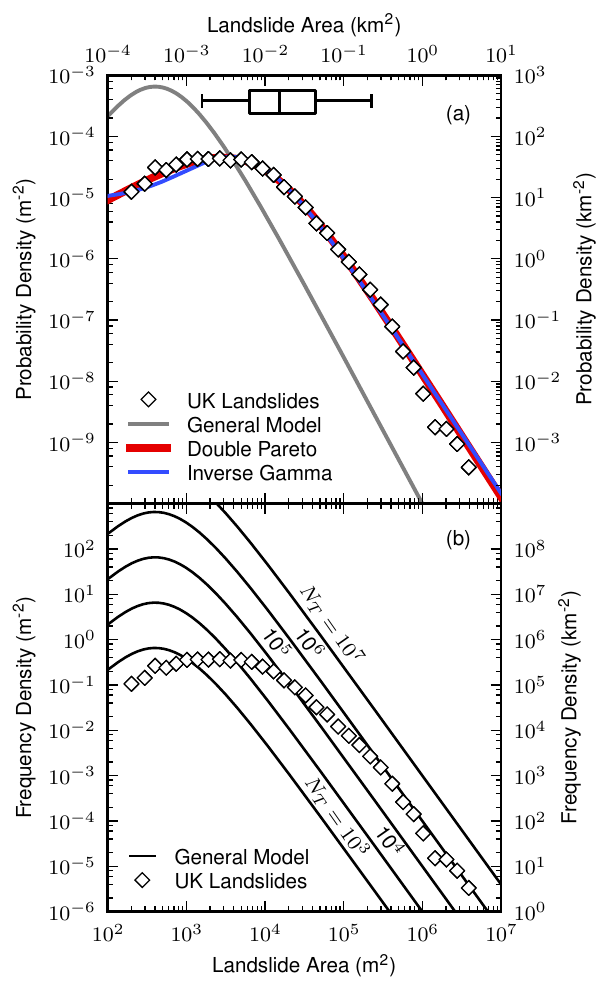
Figure 3. (a) Probability distribution of landslide deposit area for n = 8453 landslides in the UK organised into bins spaced evenly in logarithmic space (open diamonds). Solid red and blue lines show MLE of a double Pareto function ( α p = 1 . 01 ± 0 . 01; β = 1 . 71 ± 0 . 07; A peak = 8 . 09 ± 0 . 6 × 10 − 3 km 2 ) and inverse gamma function ( α g = 0 . 95 ± 0 . 02; r = 10 . 9 ± 0 . 4 × 10 − 3 km 2 ; s = − 1 . 91 ± 0 . 08 × 10 − 3 km 2 ), respectively (error ranges based on one standard deviation of boot- strapped MLE parameters). The grey line is a proposed general dis- tribution for landslides put forward by Malamud et al. (2004). Box plot shows the median (central line), upper / lower quartiles (extent of rectangle) and 5th and 95th percentiles (whiskers) of area data with a median value of 1 . 53 × 10 − 2 km 2 . (b) Frequency density dis- tribution for landslides in the UK. Solid lines represent the general distribution proposed by Malamud et al. (2004) for varying total number of landslides N T